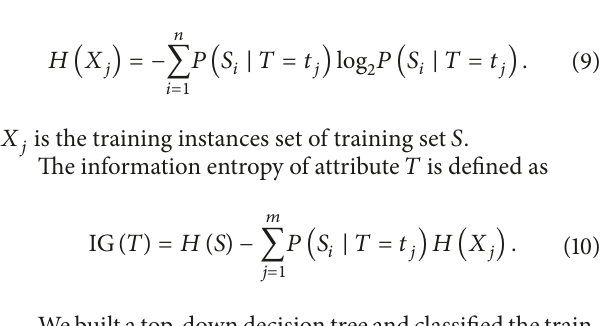
Algorithm. ID3 decision tree algorithm is a